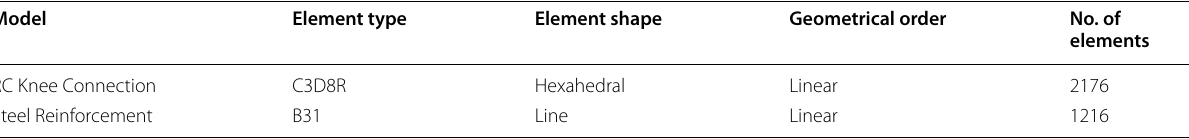
Table 7 Elements used for RC beam–column models